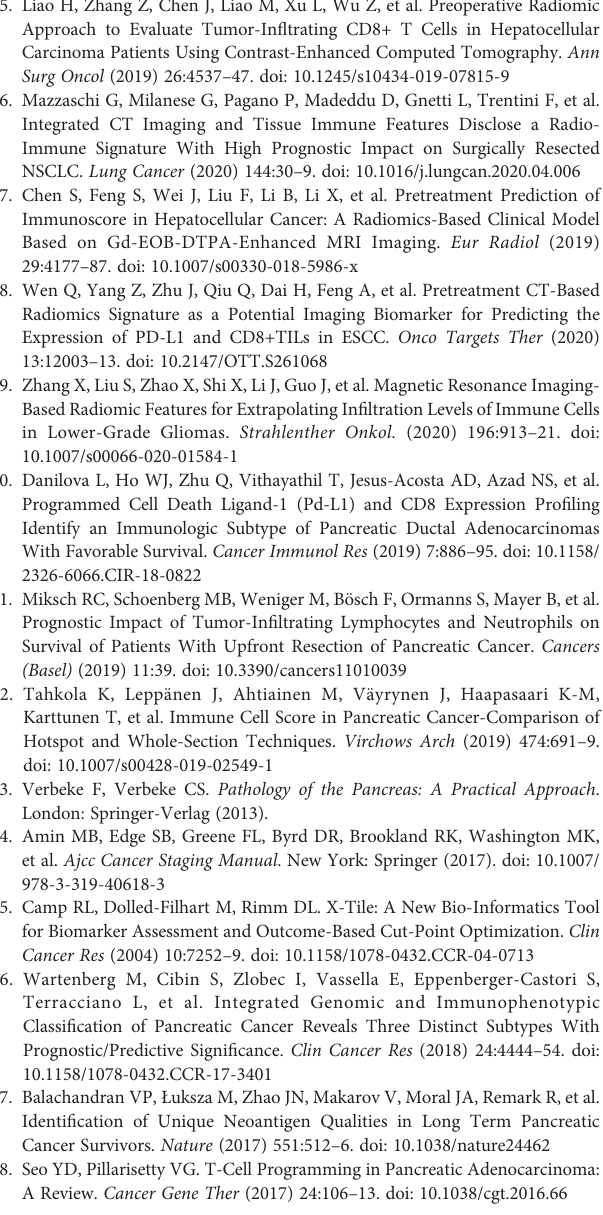
Supplementary Figure 1 | Radiomic feature selection using a parametric method, the least absolute shrinkage and selection operator (LASSO). (A) Selection of the tuning parameter ( l ) in the LASSO model via 10-fold cross validation based on minimum criteria. Binomial deviances from the LASSO regression cross- validation procedure have been plotted as a function of log ( l ). The y-axis indicates binomial deviances. The lower x-axis indicates the log ( l ). Numbers along the upper x-axis represent the average number of predictors. Red dots indicate the average deviance values for each model with a given l , and vertical bars through the red dots show the upper and lower values of the deviances. The vertical black lines de fi ne the optimal values of l , where the model provides its best fi t to the data. The optimal l value of0.05with log( l ) =-3.05 hasbeen selected. (B) LASSO coef fi cient pro fi les of the 67 texture features. The dotted vertical line is plotted at the value selected using 10-fold cross-validation in A. The 10 resulting features with non-zero coef fi cients are indicated in the plot. (C) The error-bar chart of the 10 radiomics features and radiomics